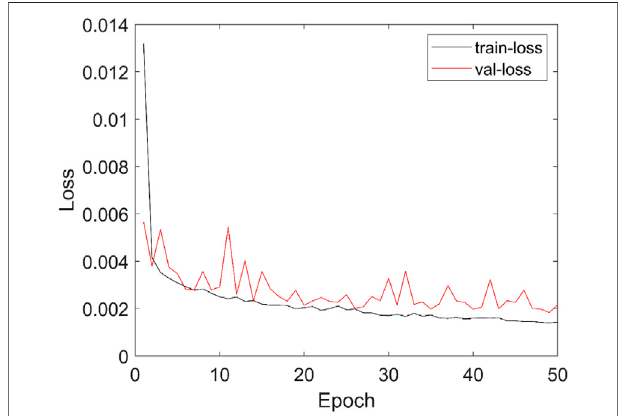
FIGURE10| Thelocationoflowilluminationareapredictedbythenetworkundertheguidanceofone-wayandtwo-wayillumination. (A) isthetargetareaand (B) is the weak illumination area of one-way illumination. (C) is the target area and (D) is the weak illumination area of two-way illumination.